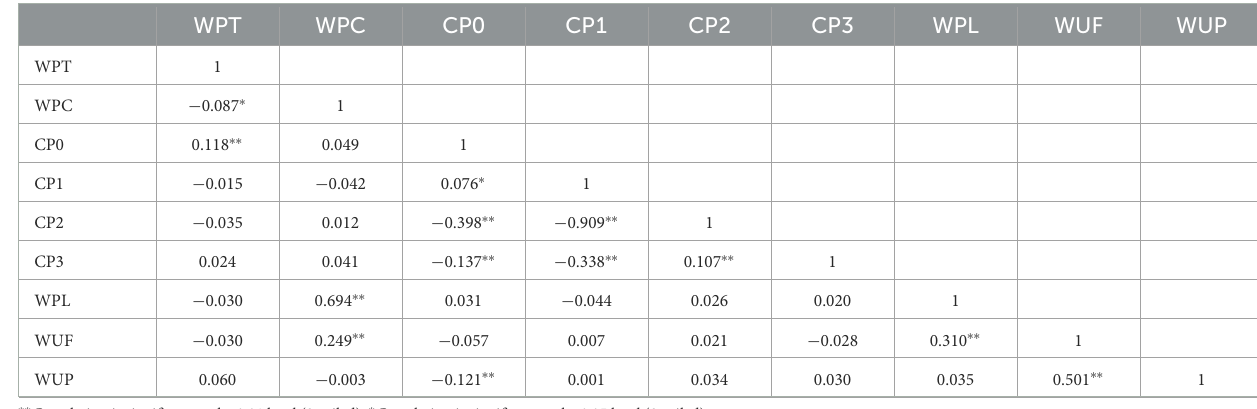
TABLE 8 Pearson correlation coefficient of the event “Fangfang